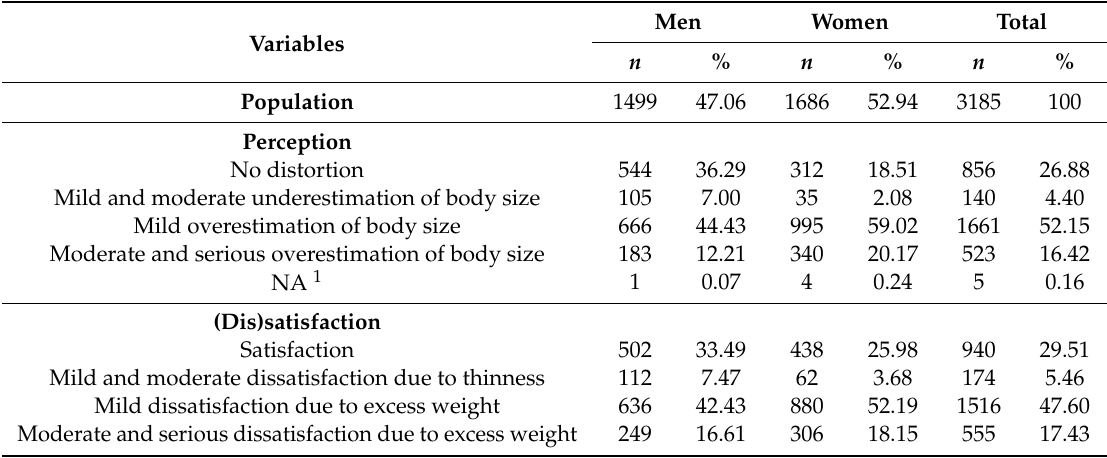
Table 3. Frequency of body size perceptions and body image (dis)satisfaction, by sex, in elderly participants in the ELSA-Brasil study (2008–2010).